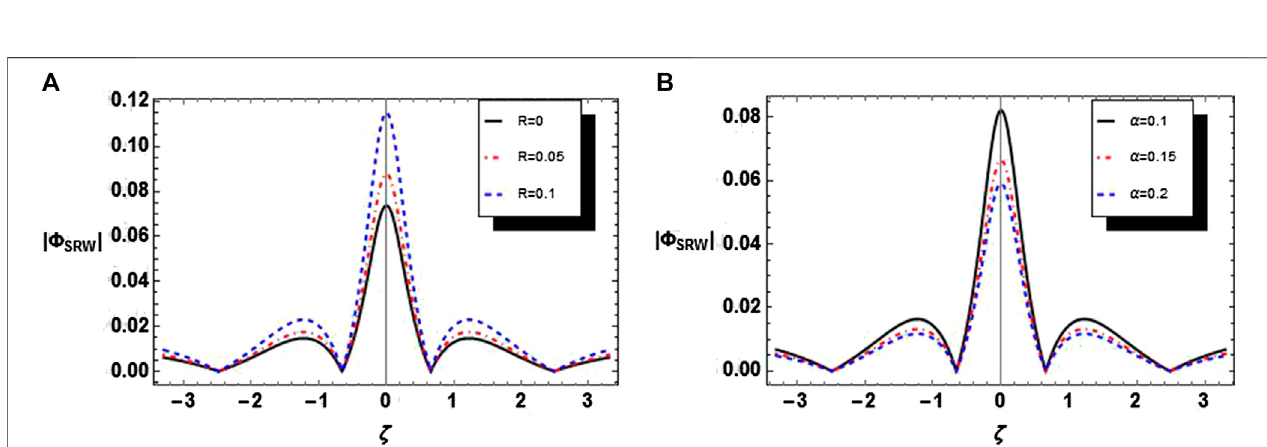
FIGURE 10 | The variation of DA-SRWs portrait vs. ζ (A) for different values of R and (B) for different values of α whereas σ (cid:1) 0 . 01 and ρ (cid:1) 1 . 11 are fi xed.